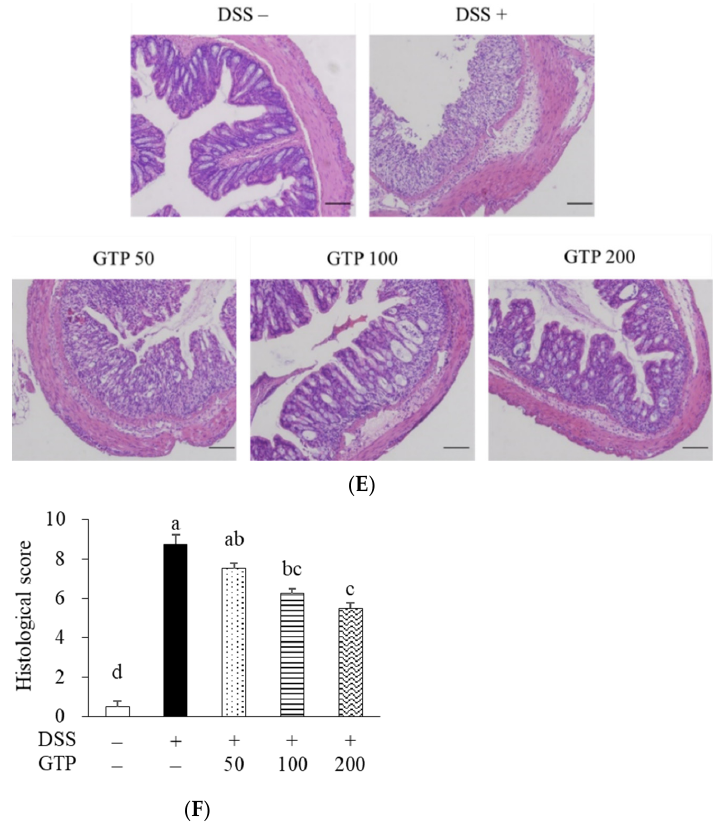
Figure 4. Effects of GTP on clinical symptoms in DSS-induced colitis in mice. ( A , B ) DAI score changes. ( C ) Colon morphology and ( D ) length. ( E ) Representative hematoxylin and eosin (H&E)-stained colon tissue (scale bars = 50 µ m; magnification of 200 × ) and ( F ) the histological score. Values are expressed as mean ± standard error ( n = 7). ( A ) Differences in mean values between the corresponding NOR and DSS groups were assessed by unpaired t ‐ test; # p < 0.05. Differences in mean values among groups were assessed by using one ‐ way ANOVA with Tukey ʹ s multiple comparison tests * p < 0.05 versus DSS group. ( B,D,F ) Bars with different letters are significantly different at p < 0.05. GTP, green tea extract containing Piper retrofractum fruit; DSS, dextran sulfate sodium; DAI, disease activity index.